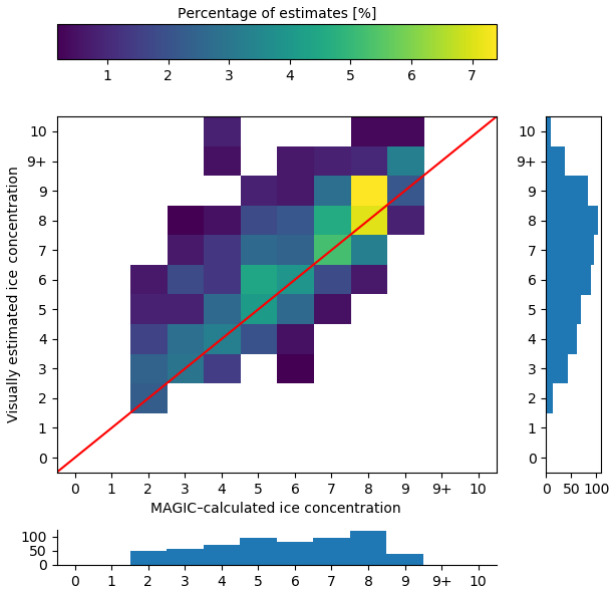
Figure 7. The contingency table of ice concentration estimated by the analysts (vertical axis) compared to concentration calculated from image segmentation (horizontal axis). This figure includes all responses from analysts, including responses where analysts indi- cated they disagreed with the segmentation results. The red diag- onal line shows the location where perfect agreement between es- timation and calculated concentration would occur. The histogram below shows the (marginal) distribution of ice concentrations for the segmentation by frequency (counts). There were no samples in the low (0, 1) or high (9 + , 10) categories. The vertical histogram shows the (marginal) distribution of ice concentration estimates re- ported by the analysts by frequency. The colour bar is scaled to rep- resent the frequency of estimates as a percentage of all responses